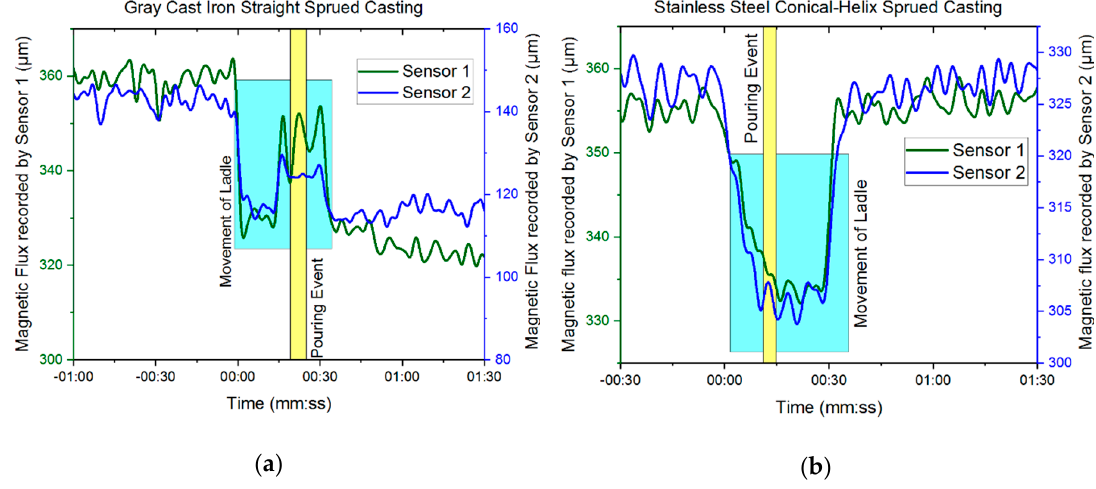
Figure 12. ( a ) Magnetic flux sensing for class 30 gray cast iron straight sprued casting. ( b ) Magnetic flux sensing for 17-4PH stainless steel conical-helix sprued casting.